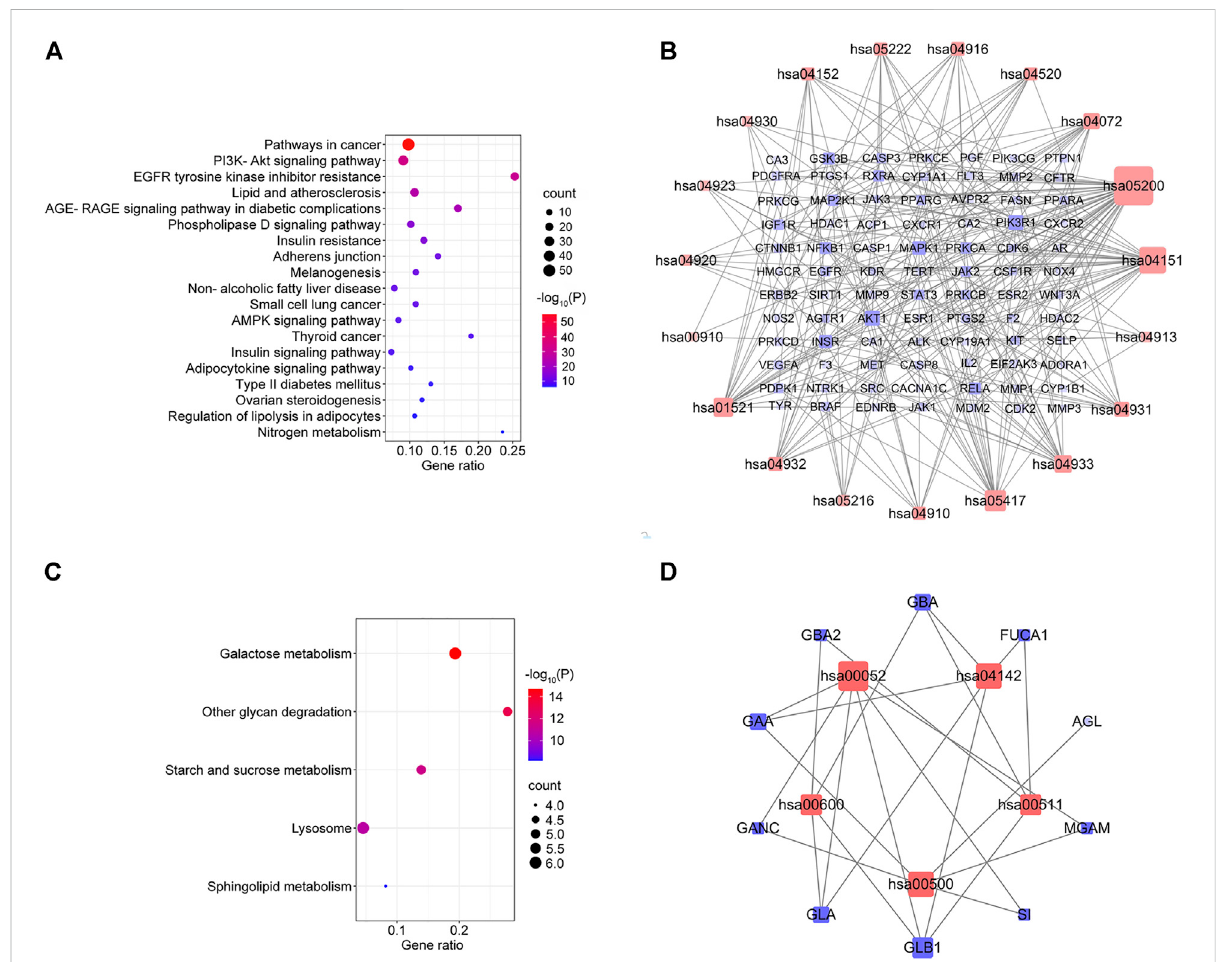
FIGURE 8 KEGG pathway enrichment analysis of the anti-diabetes targets of MLF and RMA. (A) Pathway enrichment results of MLF at p < 0.01. (B) The target – pathway network implicated in the mechanism of MLF in type 2 diabetes treatment. (C) Pathway enrichment results of RMA at p < 0.01. (D) The target – pathway network implicated inthemechanism of RMAintype2 diabetes treatment.The rednodes represent thepathways, whereasthe blue nodes represent the targets involved in these pathways. The edges represent the interactions between the targets and the pathways, and the node size is proportional to the degree of